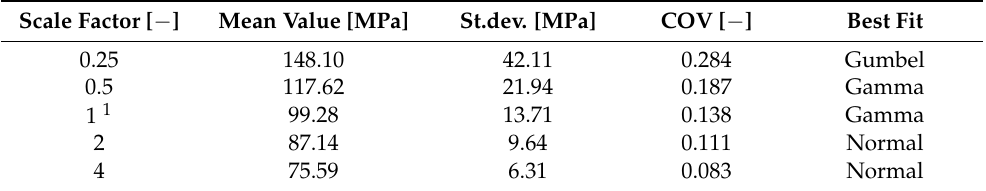
Table 4. Data for a varying scale factor.